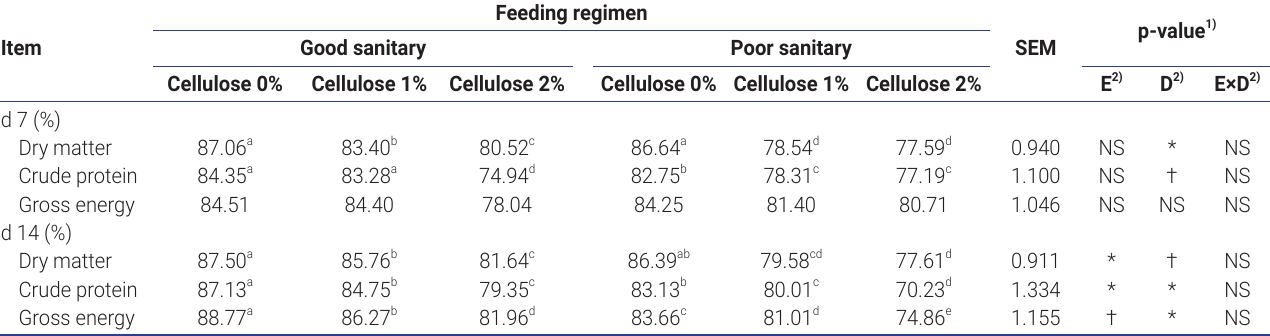
Feeding regimen